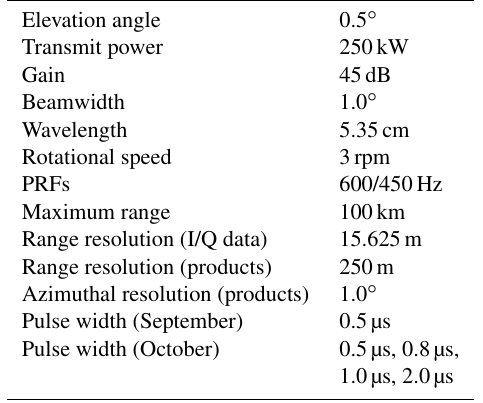
Table 1. Parameters used by the weather radar Vara during the recording of I/Q data in September and October